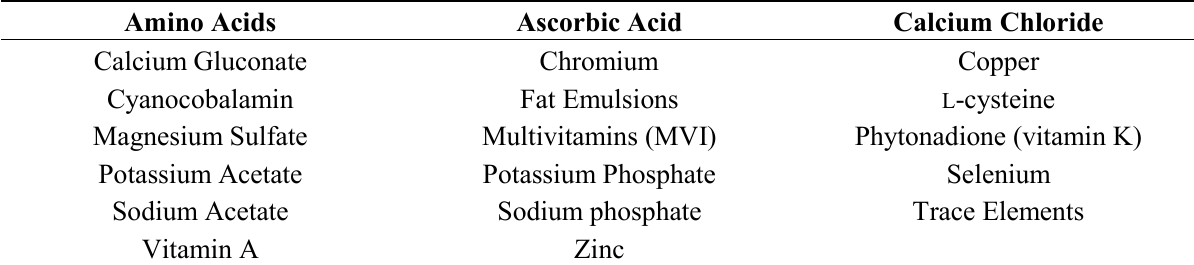
Table 1. Parenteral Shortages